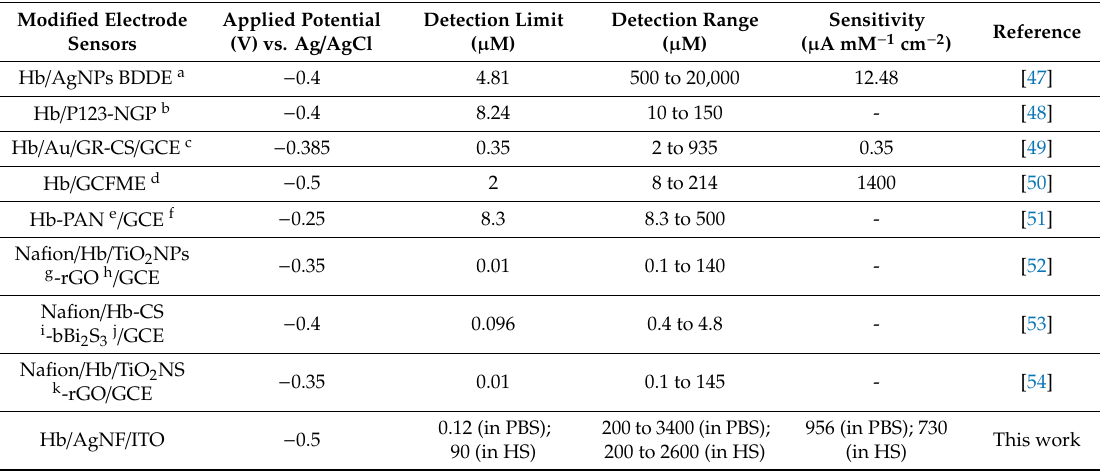
Table 2. Comparison of selected quantities measured from Hb immobilized on modified electrodes toward H 2 O 2